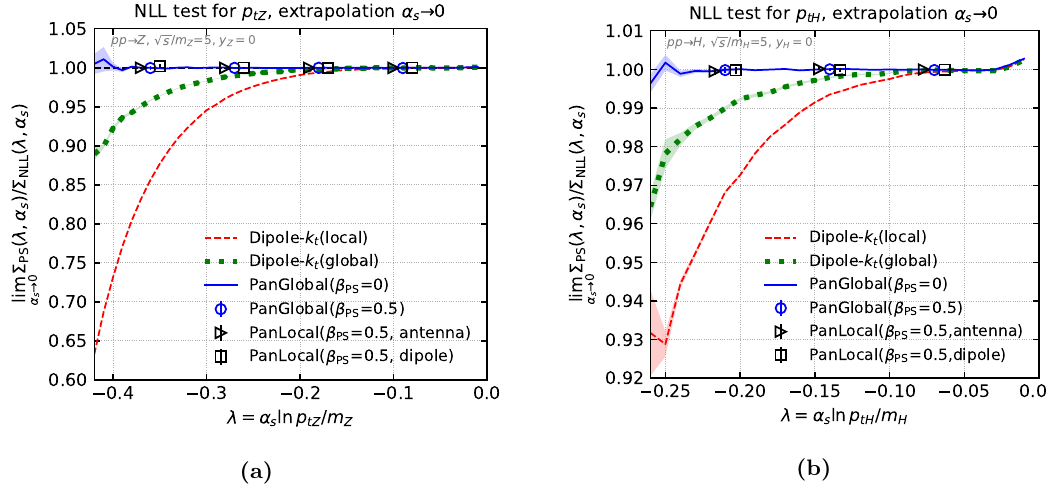
Figure 5. Ratio of the cumulative distribution for the colour-singlet transverse momentum to the NLL analytic result, in the α s → 0 limit, for (a) q ¯ q → Z and (b) gg → H events. The results are shown for Dipole- k t with local (red dashed line) and global recoil (green dotted line), PanGlobal with β PS = 0 (blue solid line) and β PS = 0 . 5 (blue circles), and PanLocal with β PS = 0 . 5 , both for the antenna (black triangles) and dipole (black squares) variants. For clarity, the PanLocal antenna (dipole) points have been slightly shifted towards the left (right), with respect to the values actually used, which coincide with the PanGlobal β ps = 0 . 5